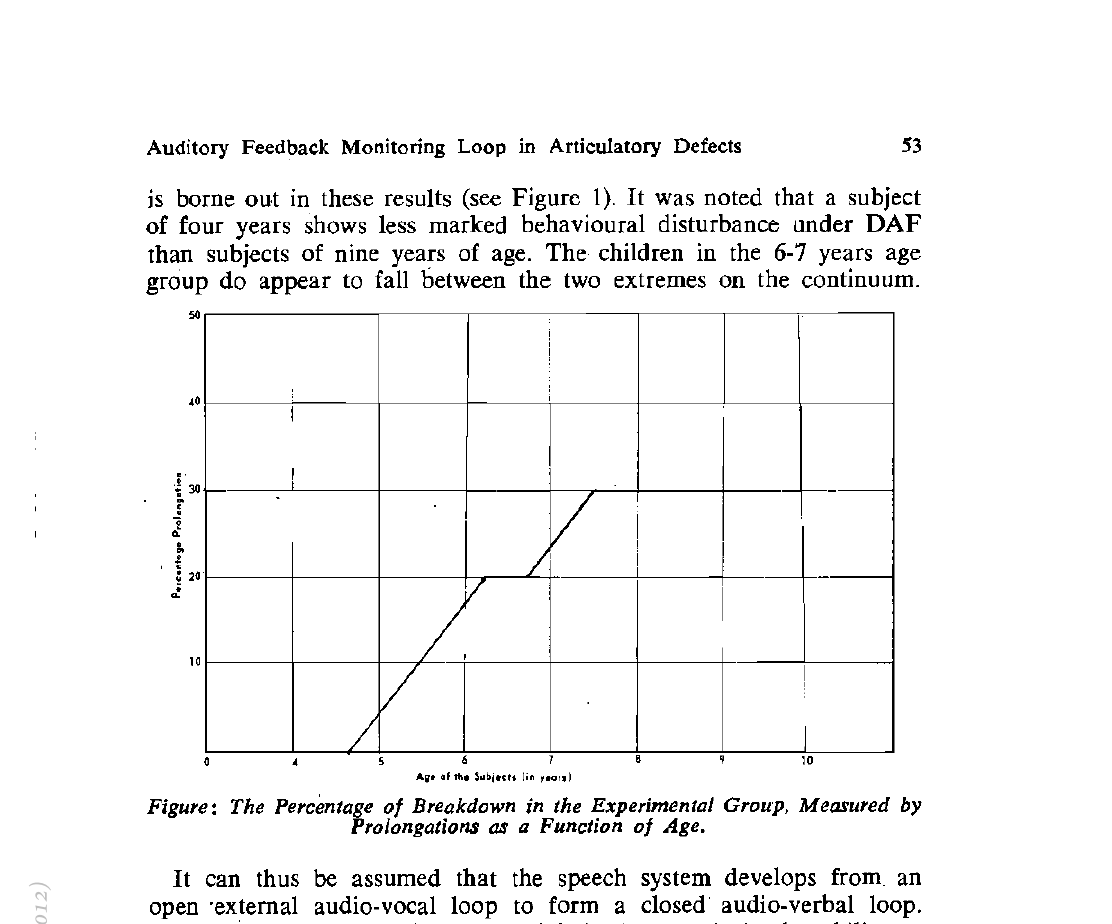
Figure: The Percentage of Breakdown in the Experimental Group, Measured by Prolongations as a Function of